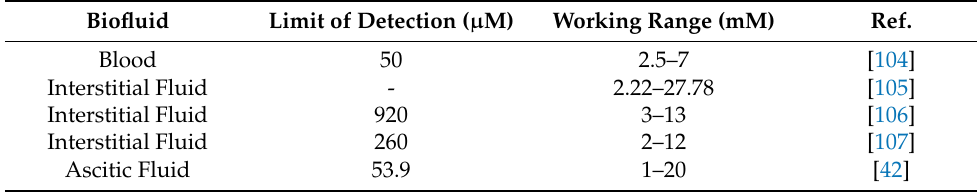
Table 5. List of smartphone-based implantable glucose monitoring